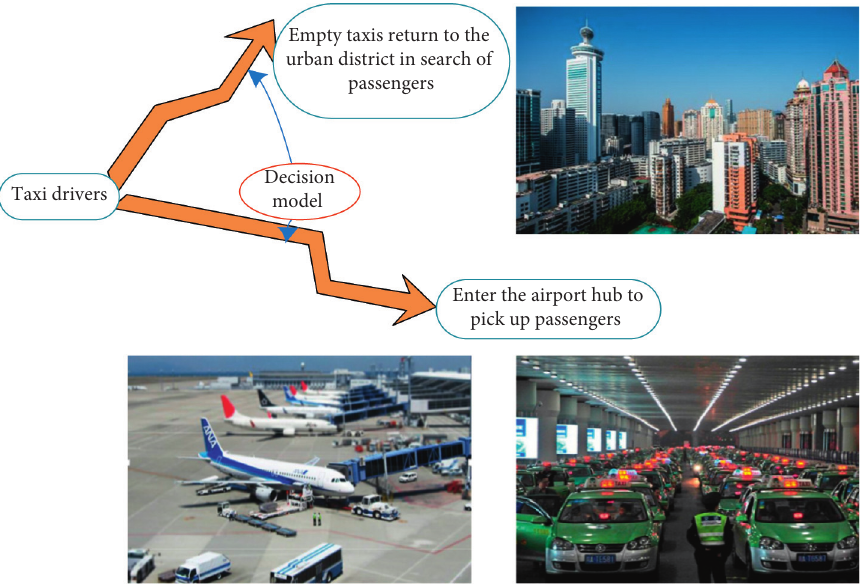
Figure 1: Taxi driver decision